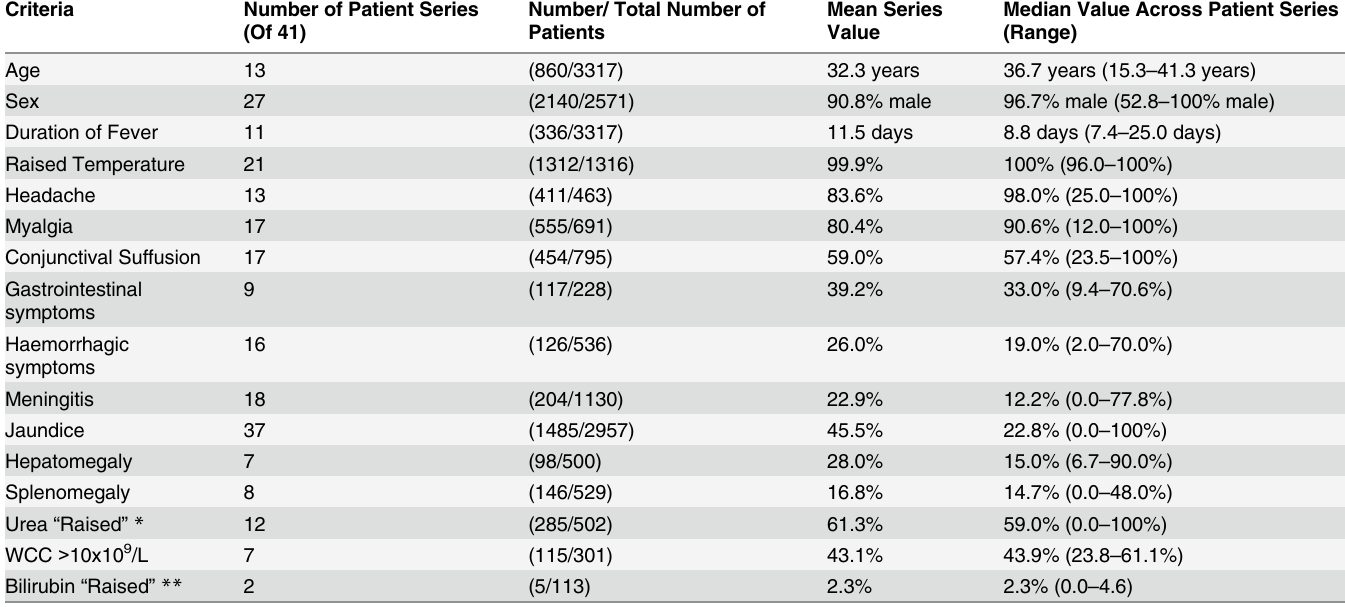
Table 2. Demographics, clinical symptoms, and laboratory data in included patient series.